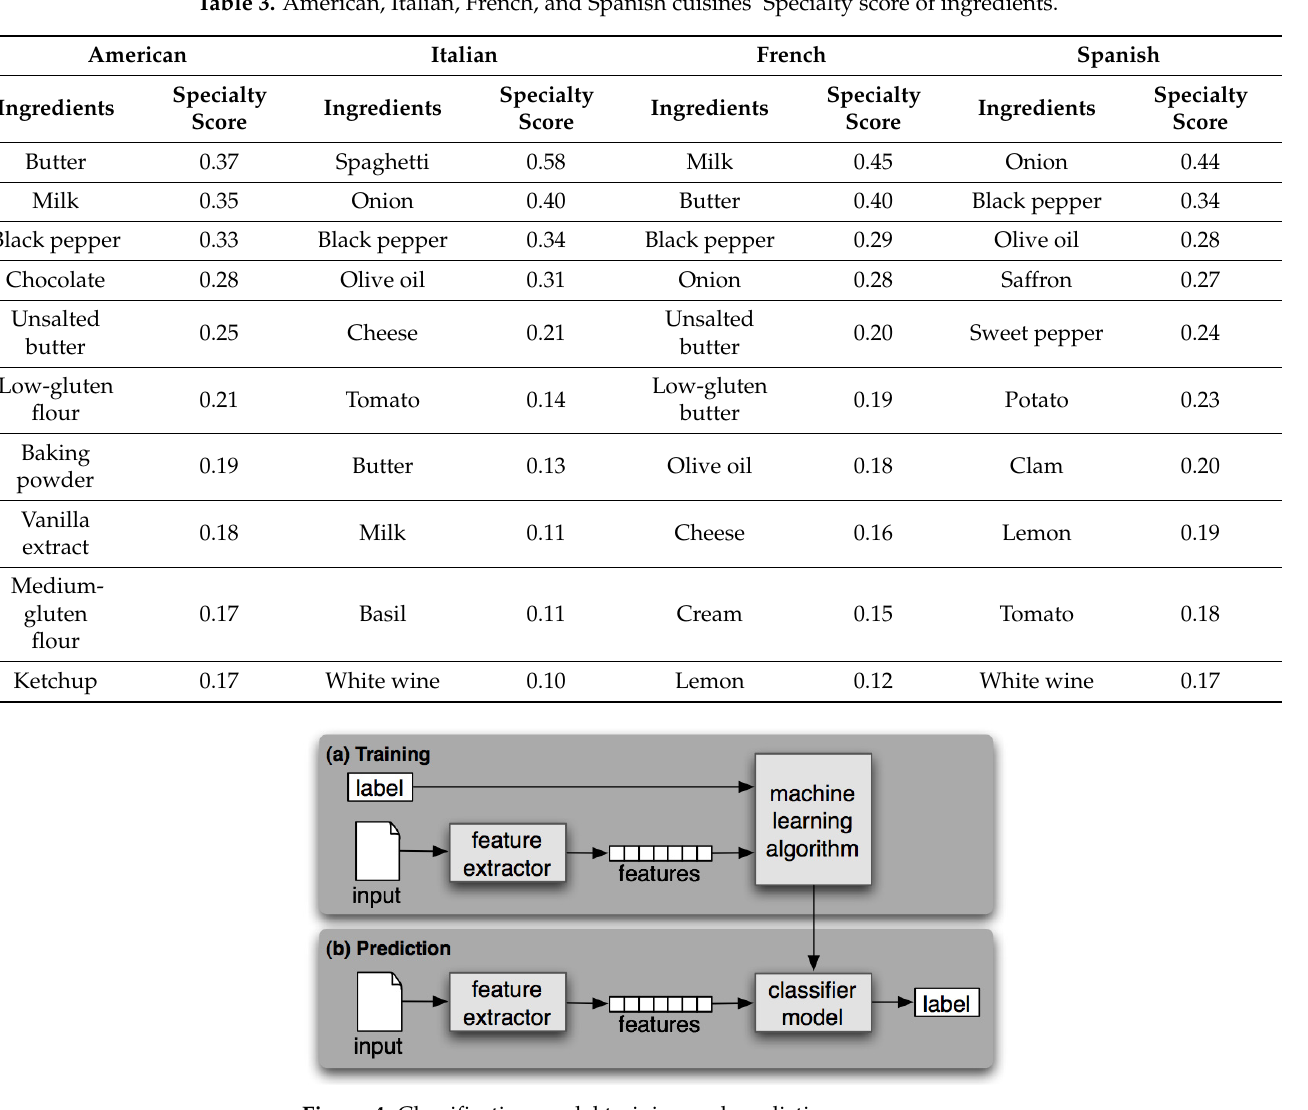
Figure 4. Classification model training and prediction process. Table 4. Performance of the SVM classifier for cuisine types.